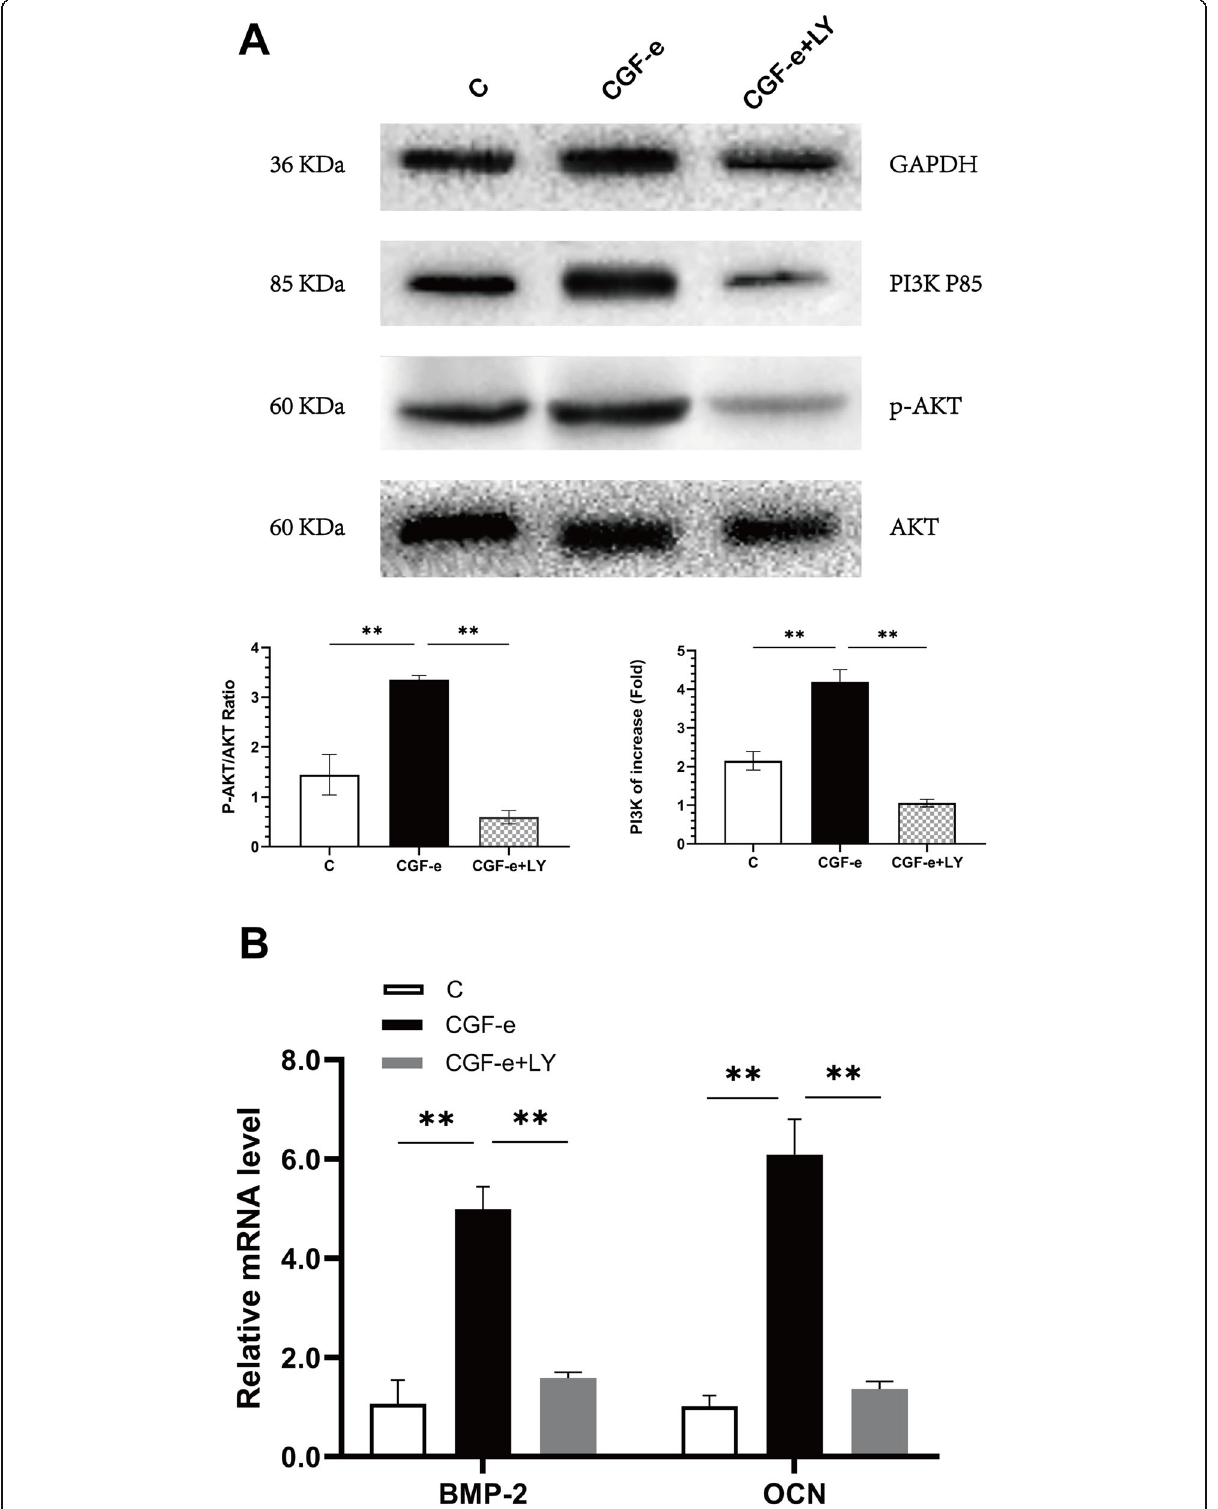
Fig. 3 (See legend on next